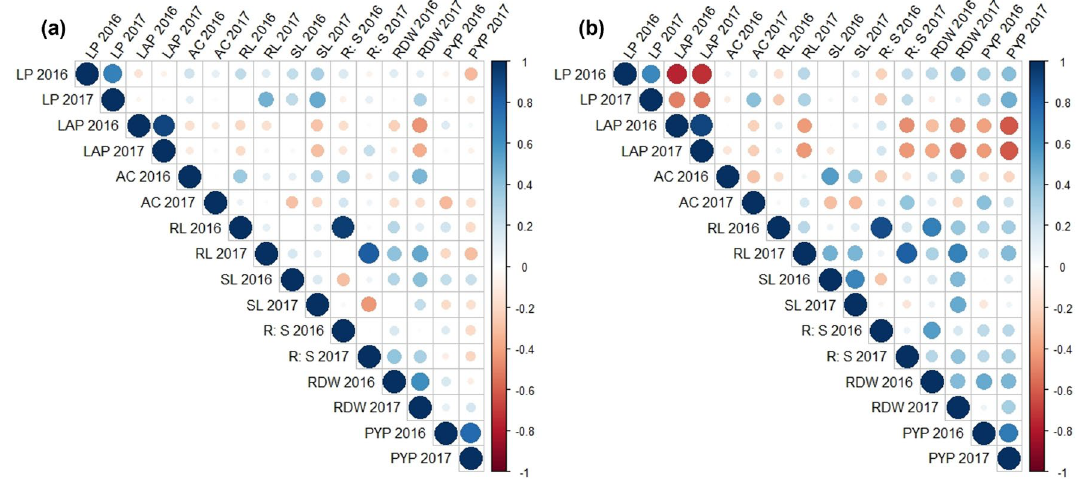
Figure 3. Correlation among the traits studied in pot (2016 and 2017) experiments under ( a ) P-sufficient condition ( b ) P-deficient condition. LP% 2016—Leaf phosphorus (%); LAP 2016– Leaf acid phosphatase (µM/ hr/gm); AC 2016– Anthocyanin content (mg/g); RL 2016– Root length (cm); SL 2016 –S length (cm); R: S ratio 2016– Root: Shoot ratio; RDW 2016– Root dry weight (g); PYP 2016– Pod yield per plant (g); LP% 2017– Leaf phosphorus (%); LAP 2017– Leaf acid phosphatase (µM/hr/gm); AC 2017—Anthocyanin content (mg/g); RL 2017– Root length (cm); SL 2017–S length (cm); R: S ratio 2017—Root: Shoot ratio; RDW 2017– Root dry weight (g); PYP 2017—Pod yield per plant (g); Blue colour circles—size and thickness represent positive correlation; Red colour—size and thickness represents negative Under P-deficient condition, in 2016 pot experiment, significant positive associations were observed between SL 2016 with AC 2016 (R 2 = 0.55*); R:S ratio 2016 with RL 2016 (R 2 = 0.88***) and RDW 2016 (R 2 = 0.55*); RDW 2016 with RL 2016 (R 2 = 0.68***) and PYP 2016 with RDW 2016 (R 2 = 0.51*). In 2017 pot experiment, positive significant association was observed between SL 2017 with RL 2017 (0.45*); R:S ratio 2017 with RL 2017 (0.81***); PYP 2017 with RL 2017 (0.44*); RDW 2017 with RL 2017 (R 2 = 0.67***) and SL 2017 (R 2 = 0.50*) and PYP 2017 with LP 2017 (R 2 = 0.48*). Whereas significant negative association was showed between LAP 2017 with LP 2017 (R 2 = −0.52*); RDW 2017 with LAP 2017 (R 2 = −0.52*); PYP 2017 with LAP 2017 (R 2 = −0.61**).